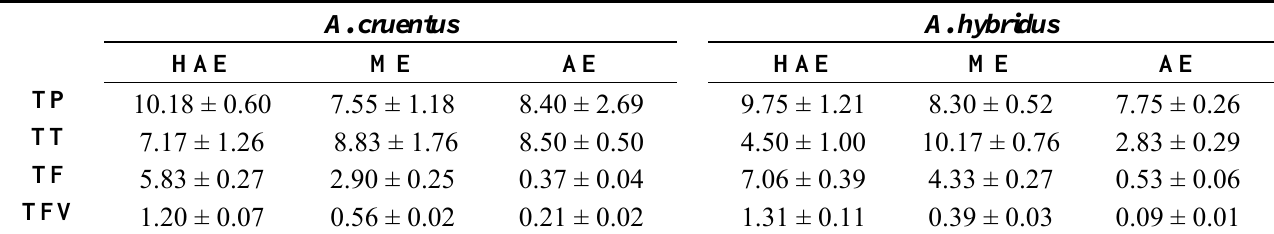
Table 4. Phenolic compounds